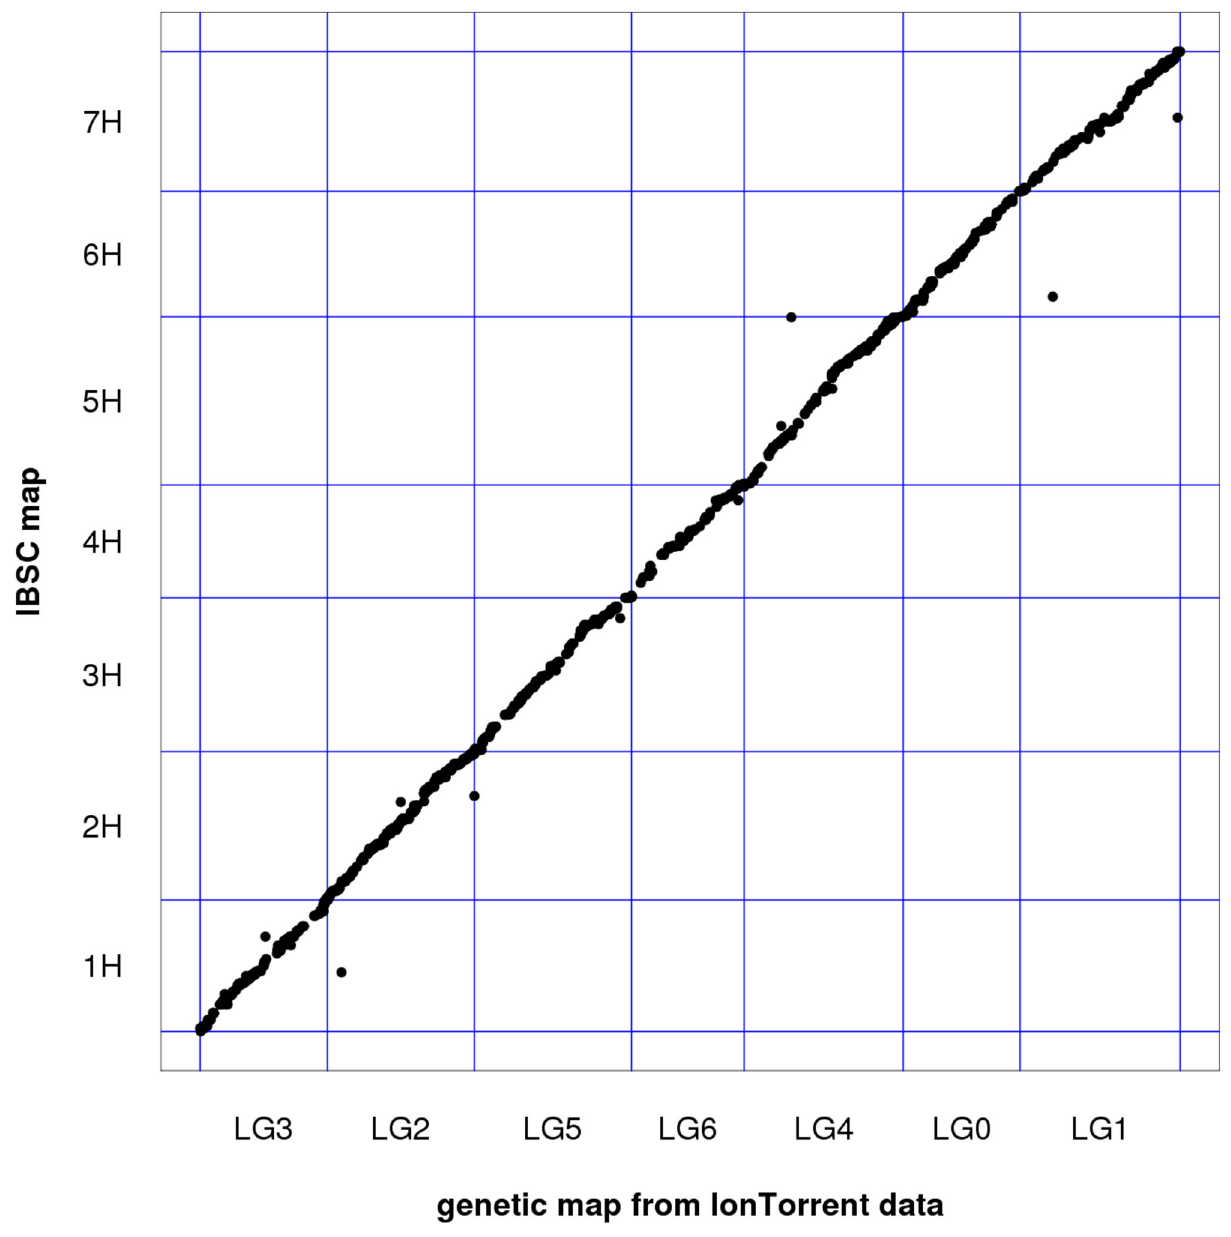
Figure 4. Genotyping-by-sequencing marker order based on the International Barley Sequencing Consortium reference framework (y-axis) compared to a de novo genetic order (x-axis) from 94 Morex x Barke recombinant inbred lines genotyped on either the Ion Torrent PGM or Proton platform. Each dot corresponds to one of 1,584 markers from the de novo map that was positioned to the physical and genetic framework of barley.